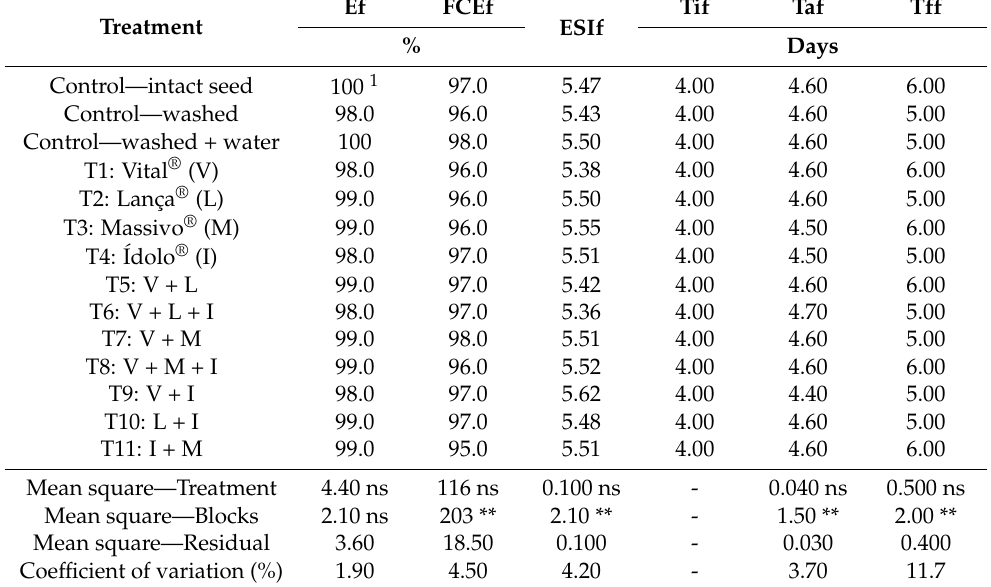
Table 6. Seedling emergence in the field (Ef), first count (FCEf) and seedling emergence speed index in the field (ESIf), abnormal seedlings (ANf), and initial, average, and final times of seedling emergence in the field of corn MG744 PWU from different seed treatments. Jata í , GO, Brazil, 2022. Ef FCEf Treatment